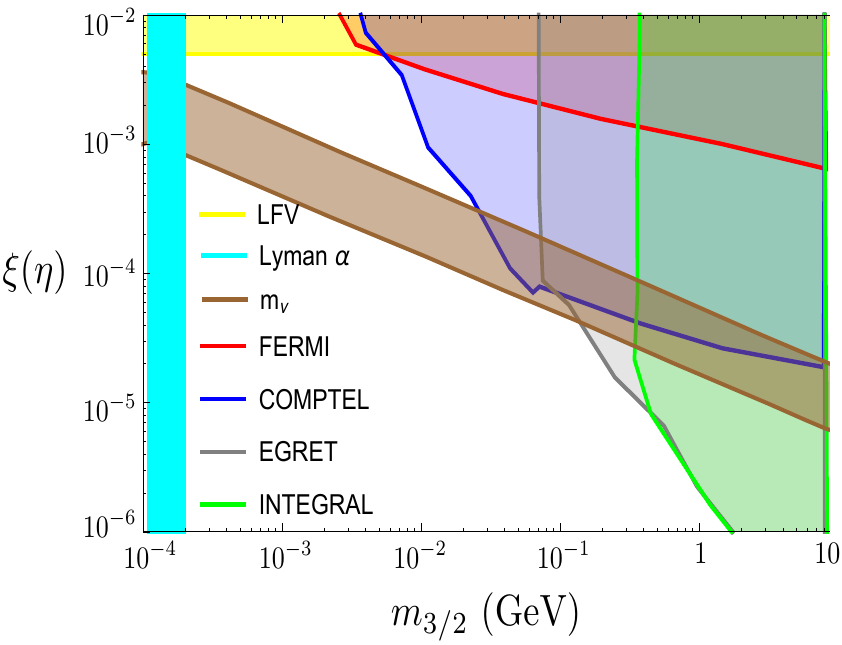
Figure 1 . We show the allowed parameter space of the model. The photon (cid:13)uxes considered from FERMI (red), COMPTEL (blue), EGRET (gray), INTEGRAL (green) experiments are translated to the (cid:24) ( (cid:17) ) (cid:0) m plane. Constraints from the Lyman- (cid:11) forest experiment rules out gravitino mass 3 = 2 less than 200 keV. We also overlay the neutrino mass constraints from eq. (3.13) where the brown shaded region satis(cid:12)es constraints from neutrino mass data. The yellow shaded region is ruled out from the lepton (cid:13)avor violating